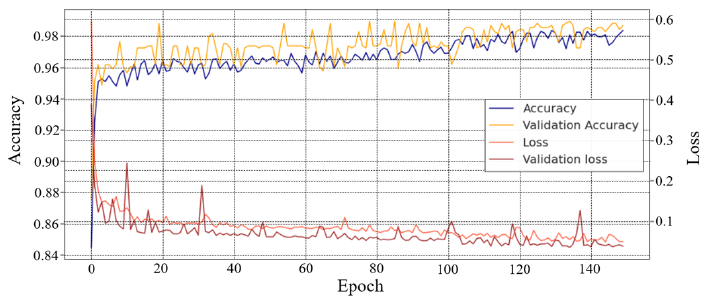
Figure 17. Training process for the LSTM model.